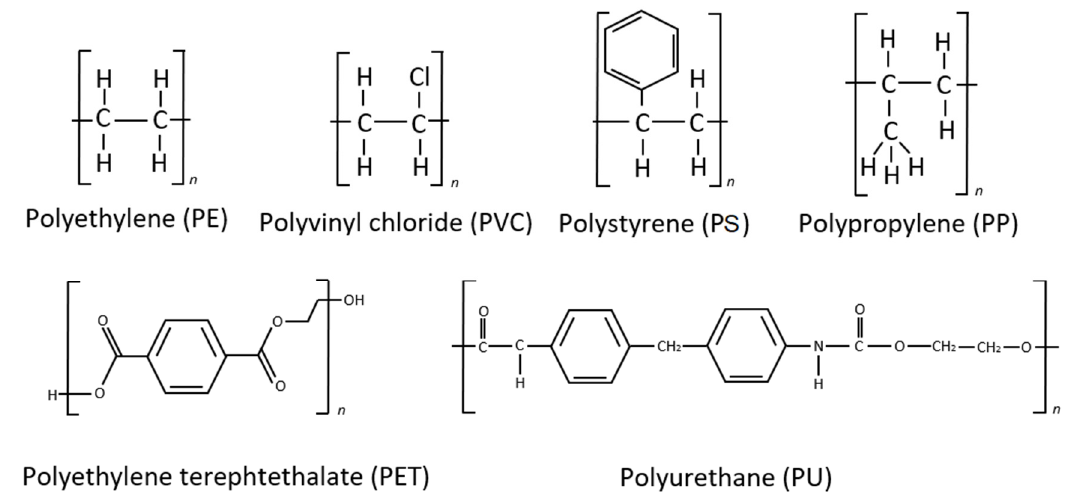
Figure 5. Structures of major commercial synthetic polymers.